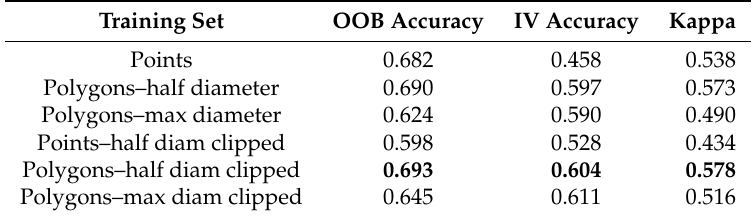
Figure 7. Mean hyperspectral reflectance from 380 to 2510 nm, extracted from all polygons with half the maximum crown diameter at the NEON NIWO site for each of the dominant tree species: ABLAL (Subalpine fir), PICOL (Lodgepole pine), PIEN (Engelmann spruce), and PIFL2 (Limber pine). Reflectance curves for all four species are overlaid here to compare and contrast their mean and standard deviation values. Shading illustrates +/– one standard deviation in reflectance per wavelength. Gaps in the spectra at approximately 1350 nm and 1800 nm are where “bad bands” were removed where there is high atmospheric absorption. Table 3. Evaluation metrics for each random forest model using a different training data set.